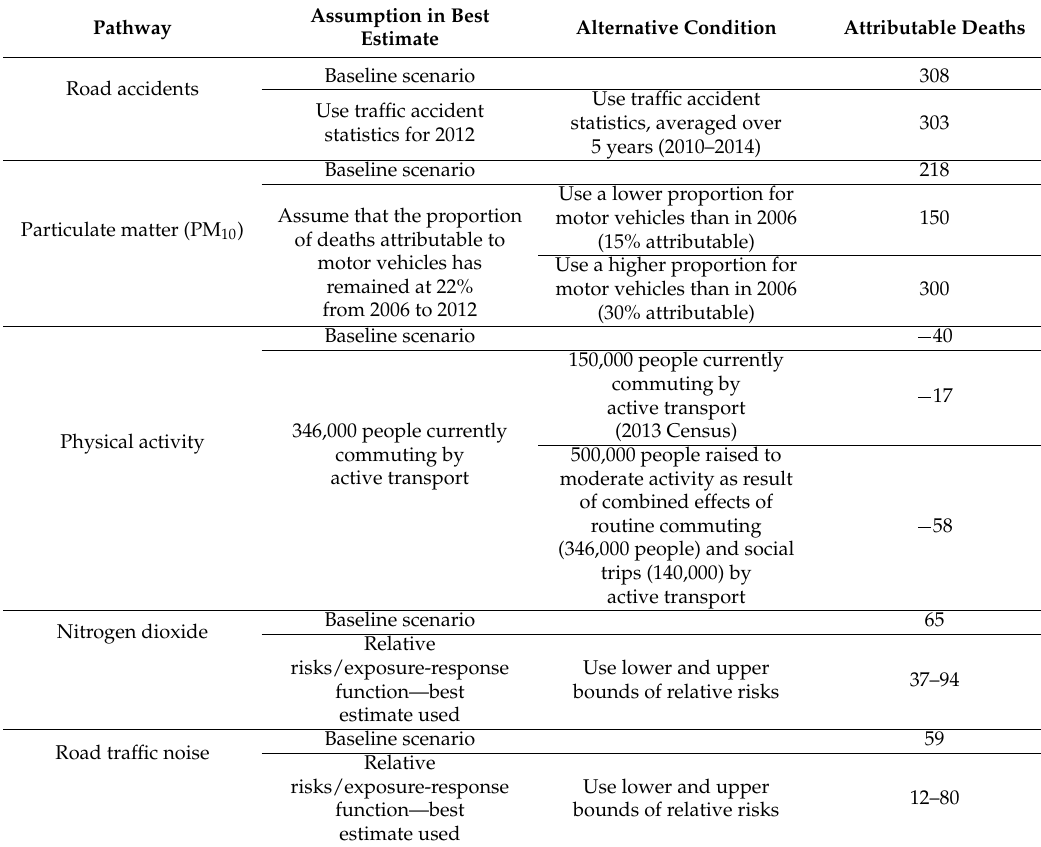
Table A2. Sensitivity